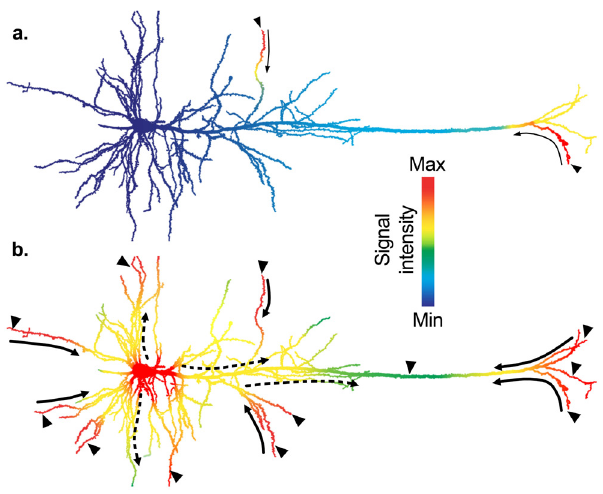
Figure 3. Activation of nuclear functions by action potentials . Excitatory synaptic activity (arrowheads) generates local changes in membrane conductance, which causes the opening of voltage gated calcium channels (VGCCs). A rise in intracellular Ca 2+ triggers the local activation of Ca 2+ -dependent signalling pathways thereby, coupling membrane depolarisation to intracellular signalling. a ) When neurons receive weak excitatory inputs (small arrowheads), the signal spread is small (thin solid arrows) and the threshold to trigger action potentials is not reached, thus somatic L-VGCCs remain closed. b ) When neurons receive strong synaptic inputs (big arrowheads), dendritic spikes can efficiently spread (thick solid arrows) in the forward direction and facilitate the initiation of action potentials at the axonal initial segment. Action potentials are backpropagated to the soma and dendrites (dashed arrows), locally generate intracellular Ca 2+ -dependent signalling cascades. Ca 2+ entry in the soma through L-VGCCs will promote the activation of protein effectors that regulate the transcription of plasticity-related genes. In this diagram, the local signal intensity representing both the electrical activity of the membrane and its coupled intracellular signalling is coded by colour. Drawings are adapted from a reconstructed biocytin-filled layer V neuron in the rat cortex (courtesy of B. Chieng and J.